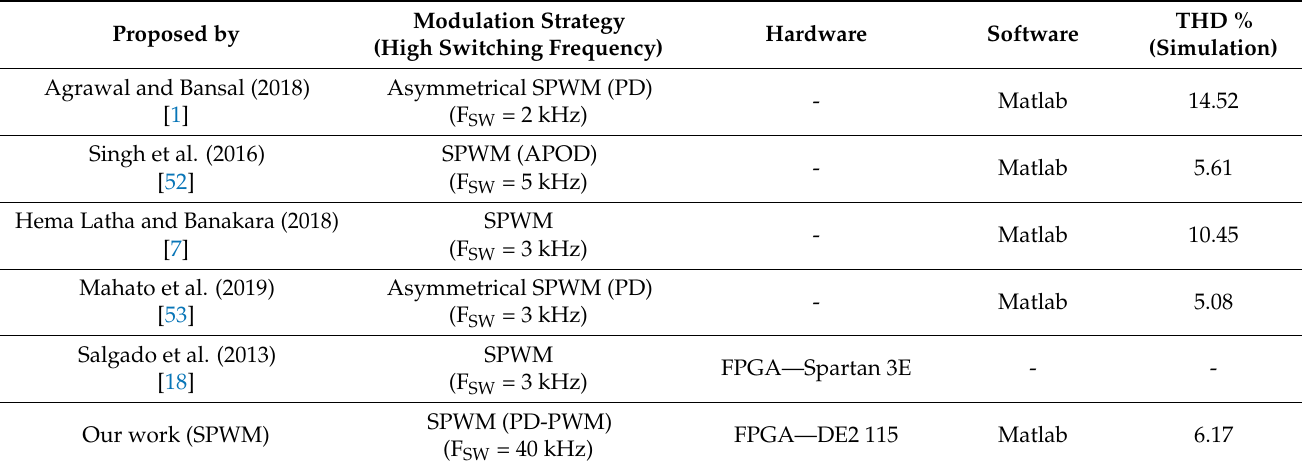
Table 13. Comparison of THD of 21-level multilevel inverter using SPWM modulation